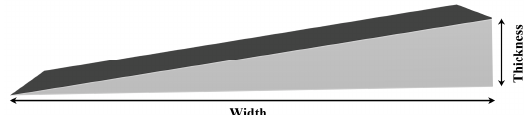
Figure 4. Scheme of half of the TEM sample in cross-section is shown (the area of minimal thickness is where hole starts). Terms “thickness” and “width” (as referred in current paper) are defined. Table 1. Width of the disordered phase layer which appears after the irradiation and respective irradiation doses. Since the width of the layers varied, the error of measurement is not shown, while it should be noted that we assess the uncertainty of the measurement in this case to be no more than 10